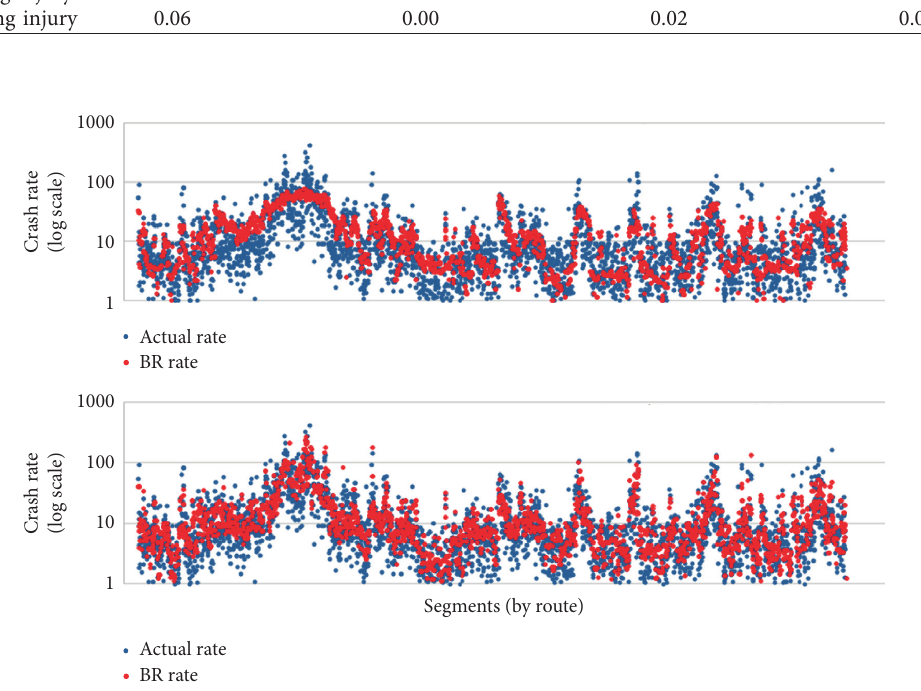
Figure 6: Crash rate models performance (2011 predictions).